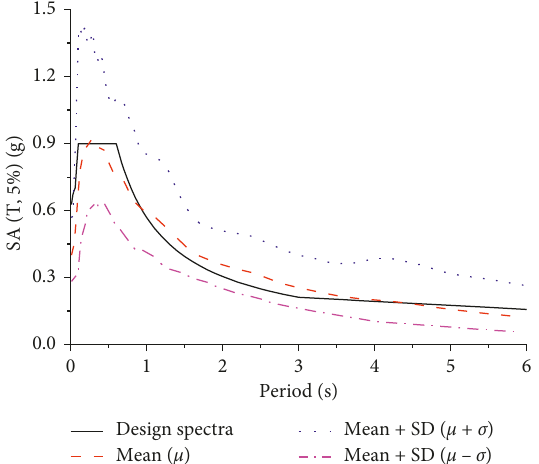
Figure 5: Response spectrums for selected records and the stan- dard design spectrums.